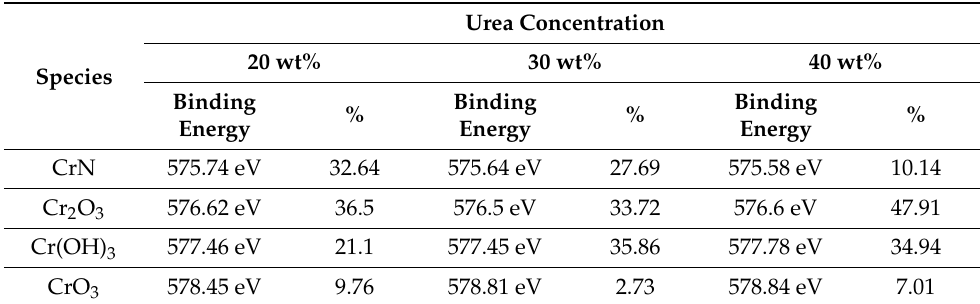
Table 1. Molecular percentages of chromium species of the oxy-nitrided AISI 304 SS samples using: